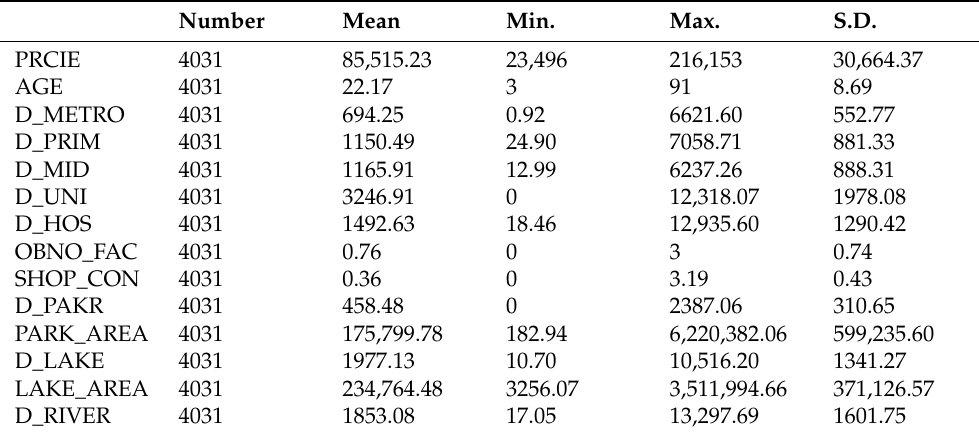
Table A1. Descriptive statistics of data in Beijing.